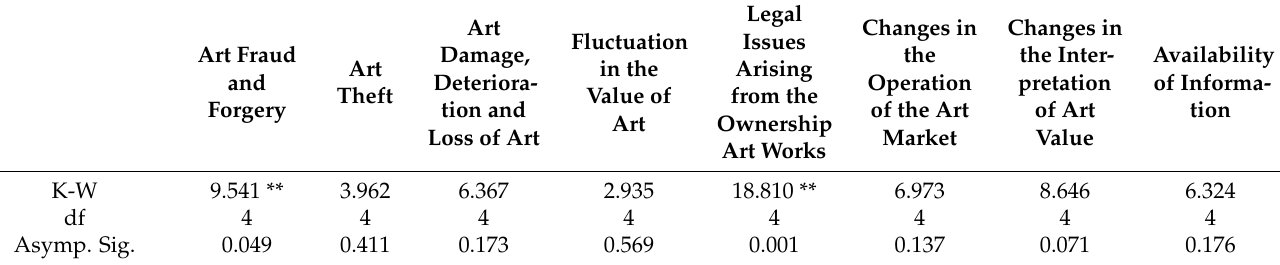
Table 7. Effects of age on art risk perception test statistics a,b